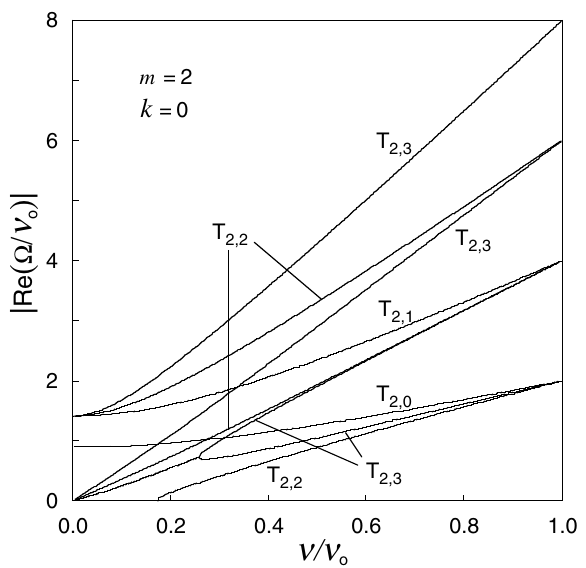
FIG. 7. Absolute value of the real part of (cid:13) =(cid:10) nine quadrupole modes as a function of (cid:10)=(cid:10) 1 : 5 , and zero wall